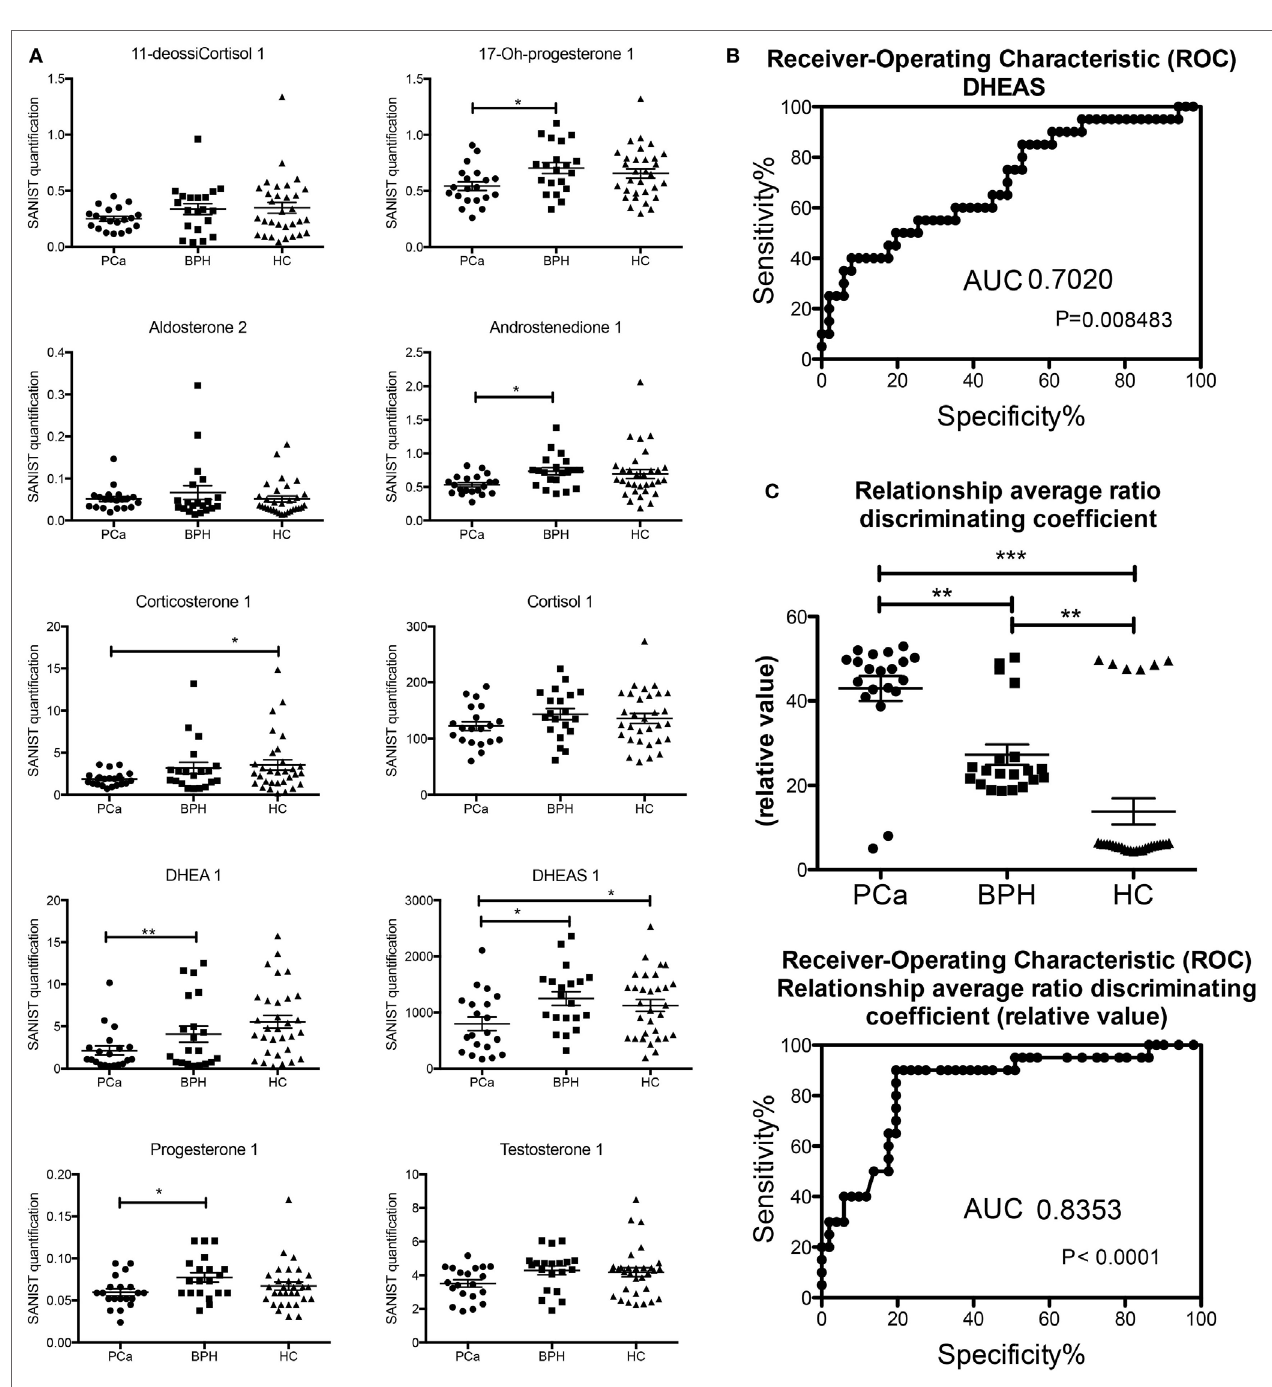
FigUre 2 | (a) Classic analysis of absolute concentrations of the steroids. (B) Receiver-operating characteristic (ROC) curve of dehydroepiandrosterone sulfate based on the classification in Table 1 . (c) Analysis of the output of the machine learning (based on the classification in Table 1 ) and ROC of the values obtained (* p < 0.05; ** p < 0.01; p < 0.001 one way ANOVA, Graphpad Prism